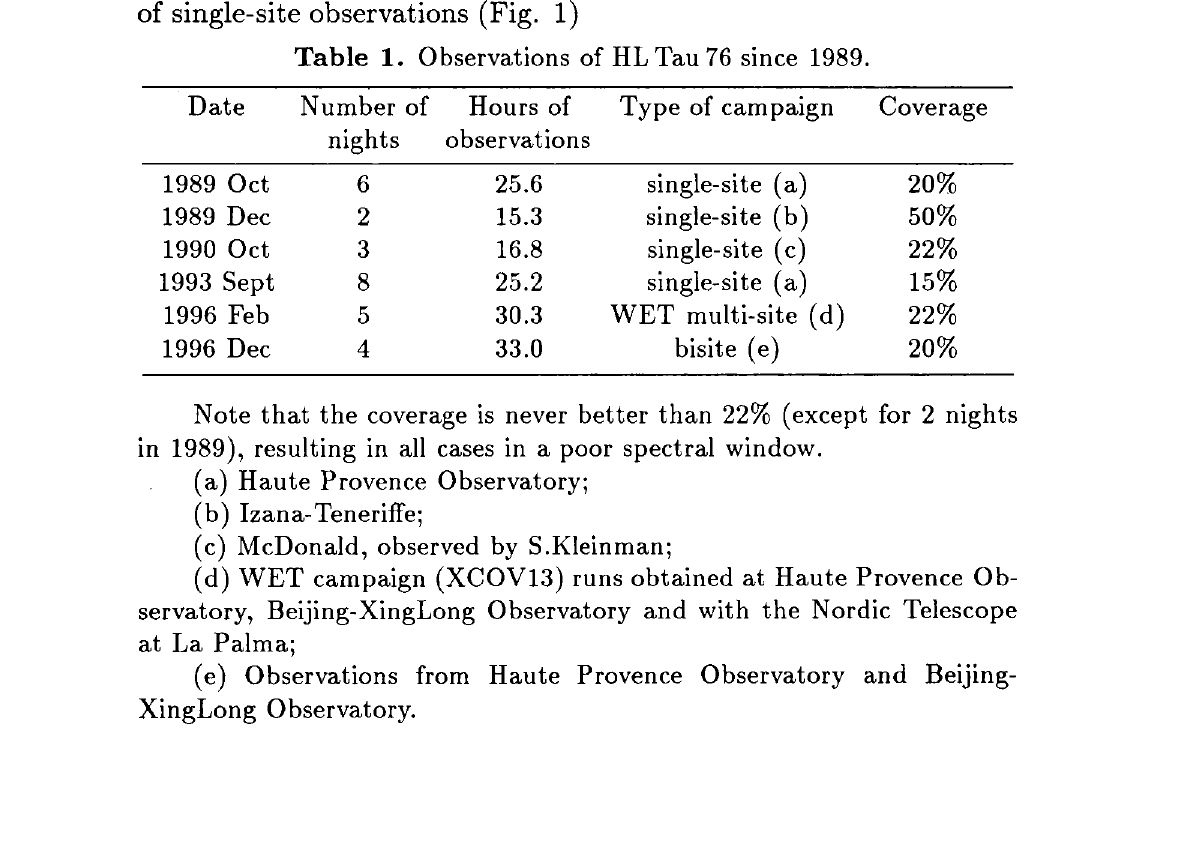
Table 1. Observations of HLTau76 since